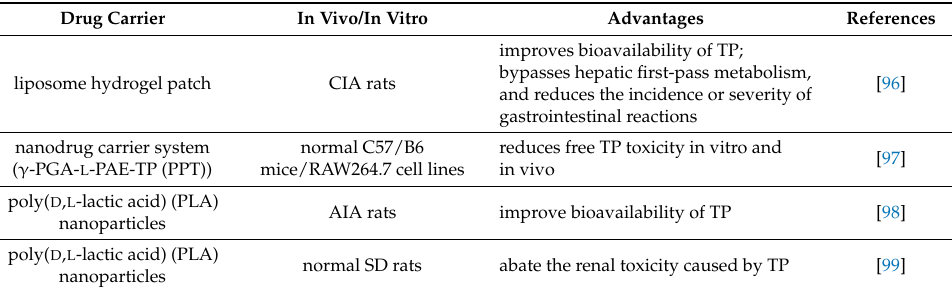
Table 2. Innovative delivery system studies of